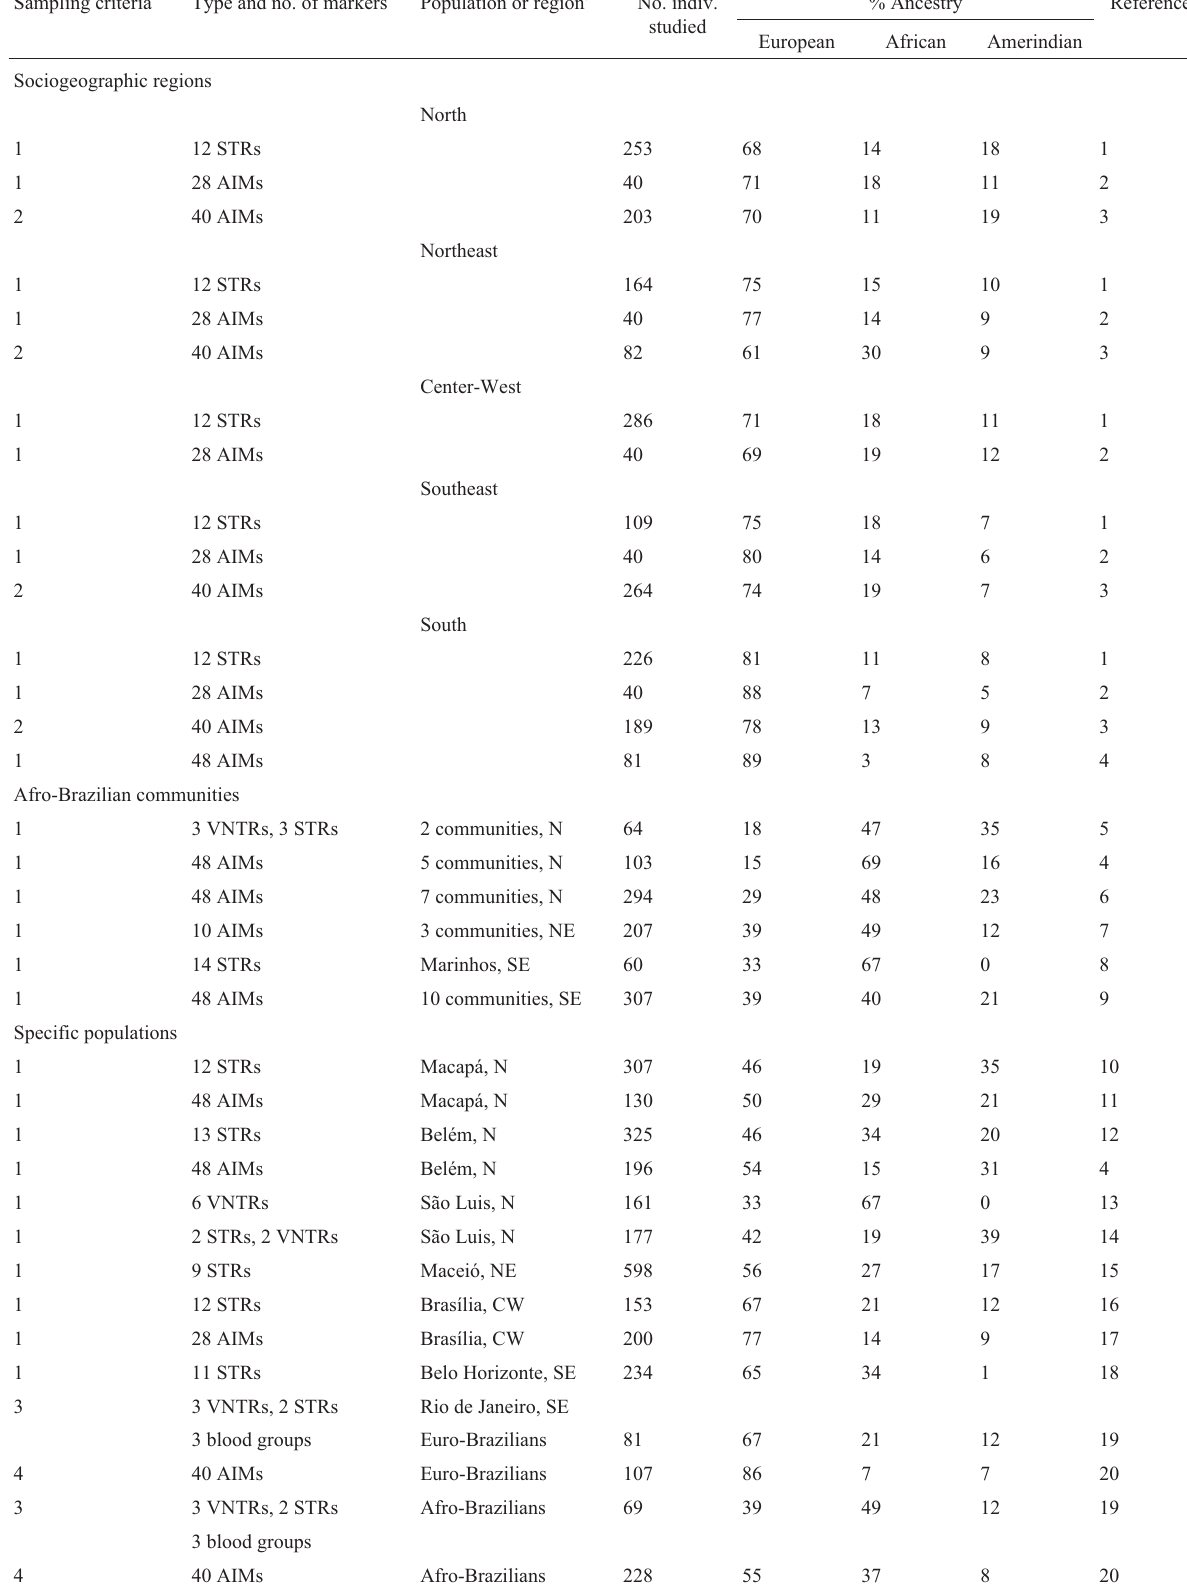
Table 4 - Autosome estimates of parental continental ancestry in different segments of the Brazilian population 1 . Sampling criteria